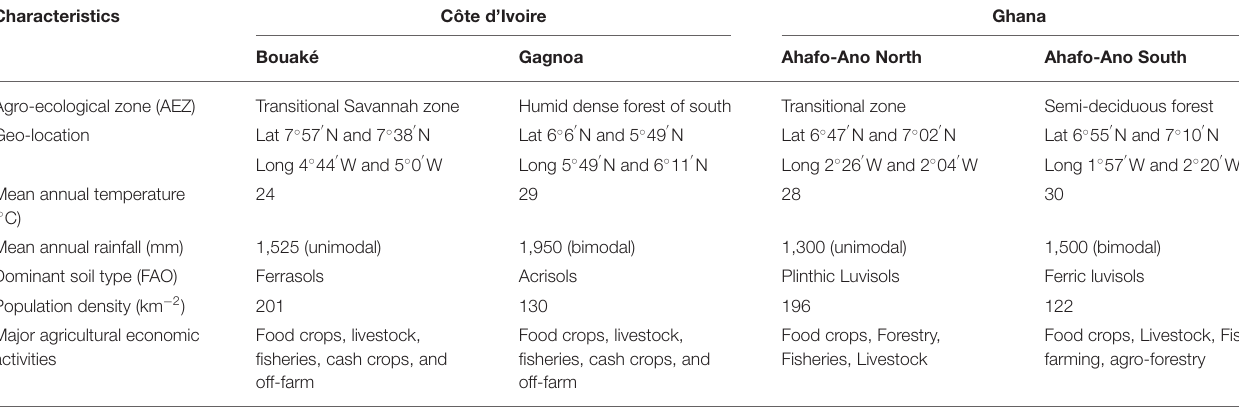
TABLE 1 | Main characteristics of the selected regions in Côte d’Ivoire and Ghana (2018–2019). Characteristics